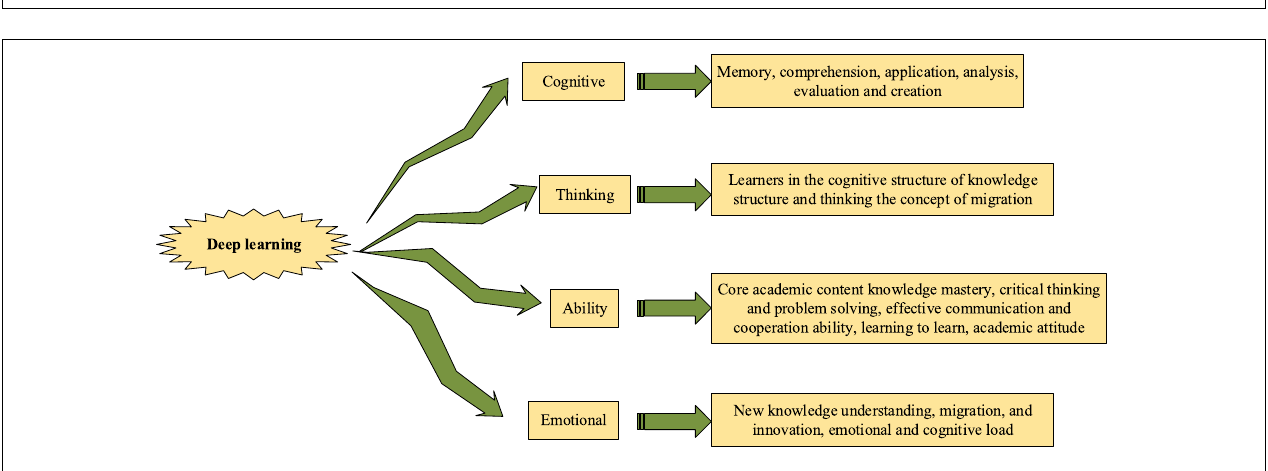
FIGURE 1 | Comparison of deep learning and shallow learning.